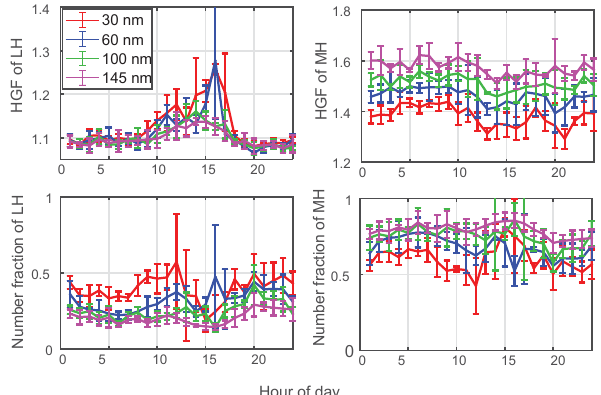
Figure 3. Diurnal variation of the HGF of less-hygroscopic (LH) and more-hygroscopic (MH) mode particles and their respective number